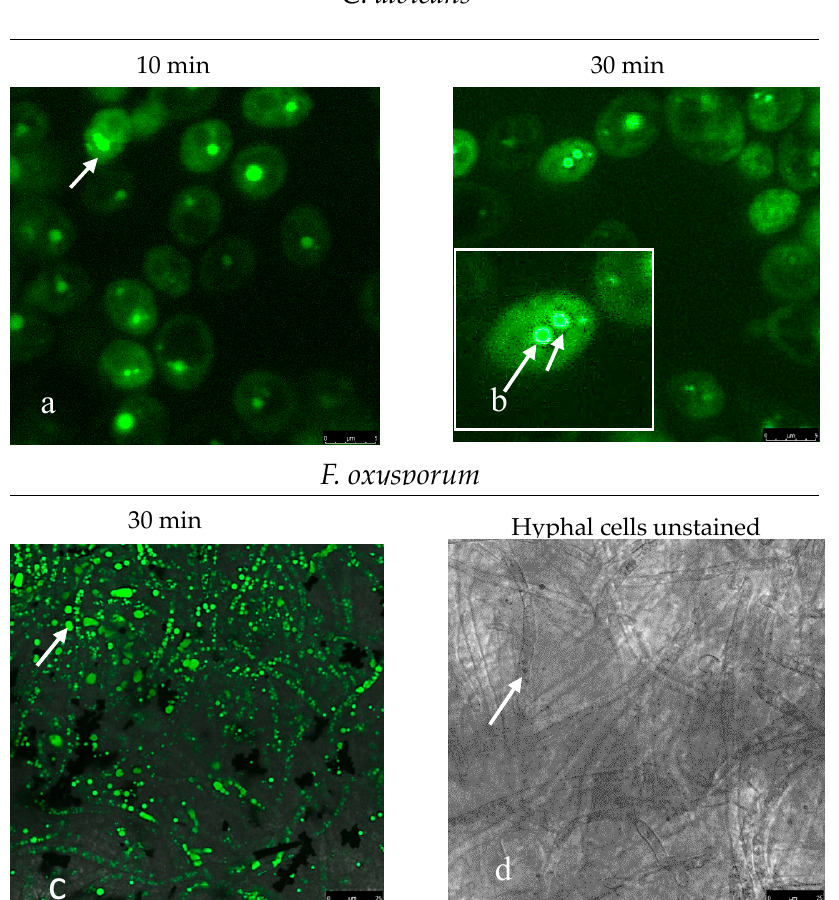
Figure 4. CLSM of fungal cells of C. albicans and F. oxysporum. The scale bar is 5 microns. Photos ( a , b )—cells of C. albicans fungi (after 10–30 min staining with [BF 2 L], intensely stained nuclei and membranes of the structural components of the cell are visible. Photo ( c )—hyphal, multinucleated fungus F. Oxysporum cells (after 30 min staining with [BF 2 L] intensely stained nuclei and membranes of the structural components of the cell are visible). Photo ( d )—hyphae of the fungus F. Oxysporum (unpainted preparation).